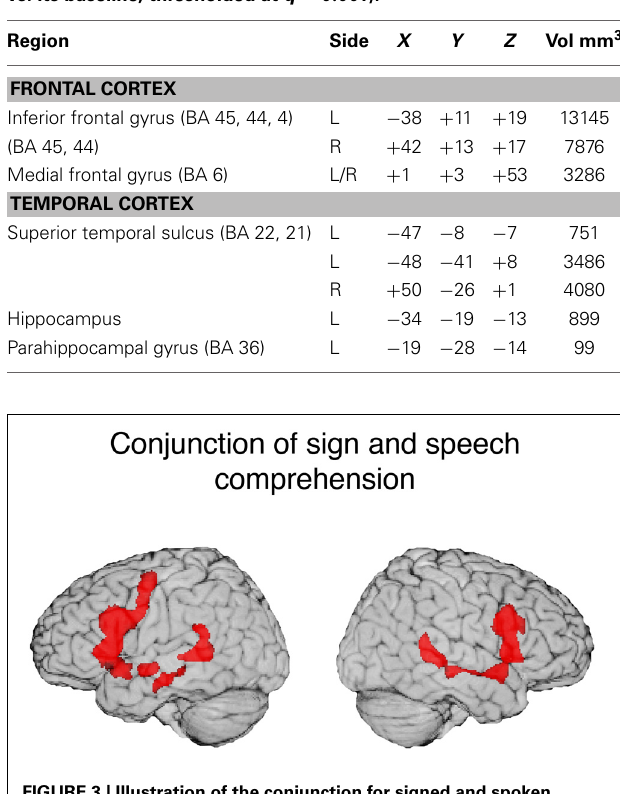
FIGURE 3 | Illustration of the conjunction for signed and spoken language comprehension. The red regions (overlaid onto an individual human brain) were active for both signed and spoken language comprehension relative to the baseline (threshold at q = 0 . 01). Conjunction of common activations up to 30mm beneath the surface of cortex are